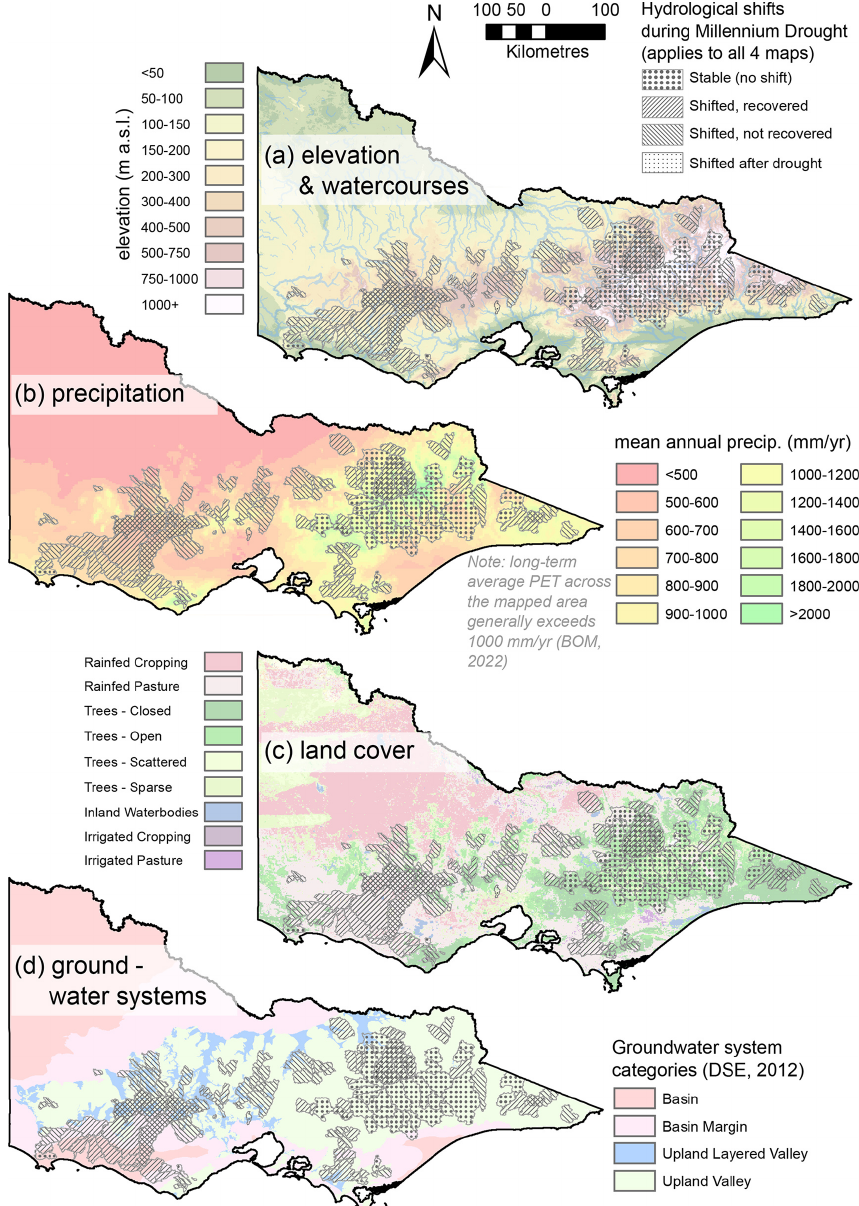
Figure 7. Maps of the state of Victoria, showing various attributes used to assess HPEs by their spatial consistency. Each map is shown with 156 catchments categorised by Saft et al. (2019). Note that a given location in space can be marked with more than one Saft et al. (2019) category due to nestedness (i.e. if it is upstream of two gauges in different categories). Data sources are listed in Table